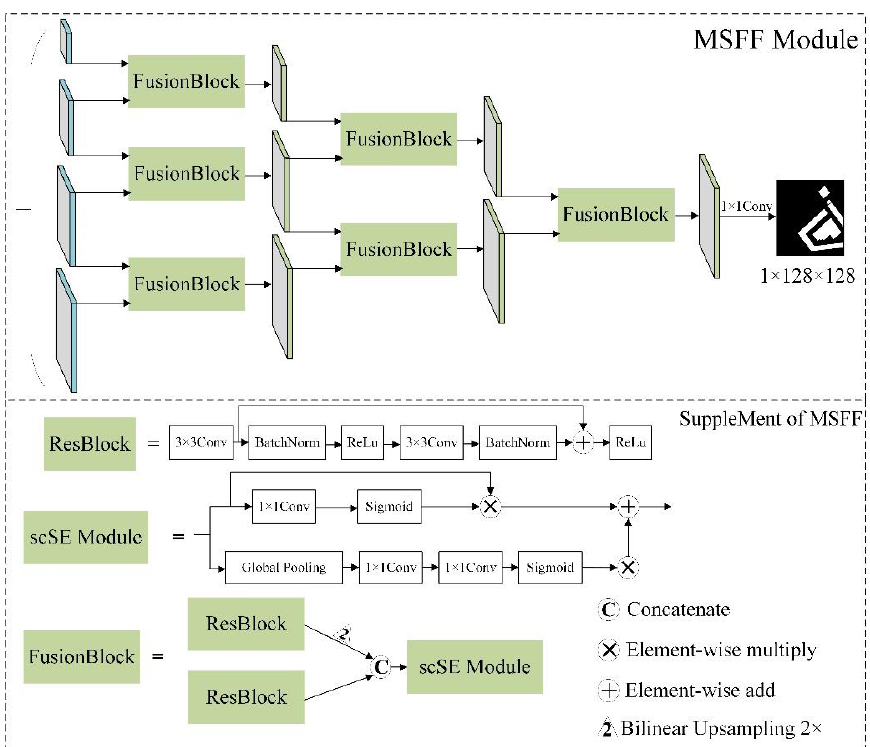
Figure 3. A diagram of the MSFF module. Its basic unit is FusionBlock composed of residual block and the scSE module. The feature maps of adjacent scales were successively passed through FusionBlock to output high-resolution fused feature maps. The MSFF module contained six FusionBlocks, and finally applied a 1 × 1 convolutional layer and softmax function to obtain the classification results.